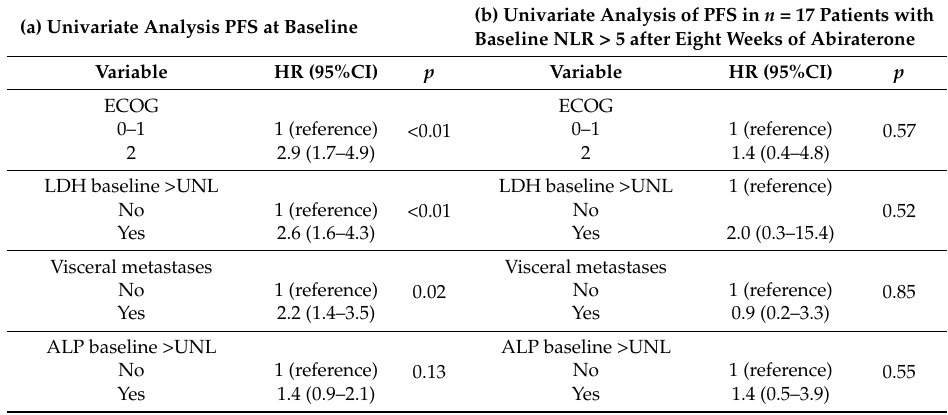
Table 2. Univariate analysis for baseline biomarkers for progression-free survival in (a) 96 mCRPC-patients prior to Abiraterone therapy and (b) in 17 patients with a baseline NLR >5 after eight weeks of